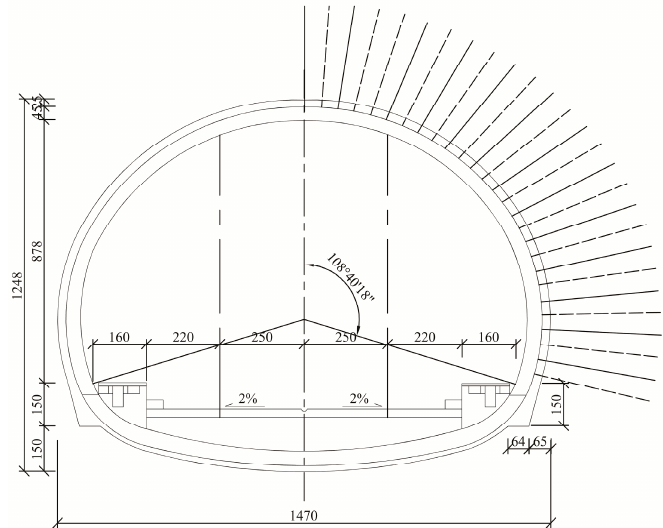
Figure 1. Layout of tunnel section (unit: cm).